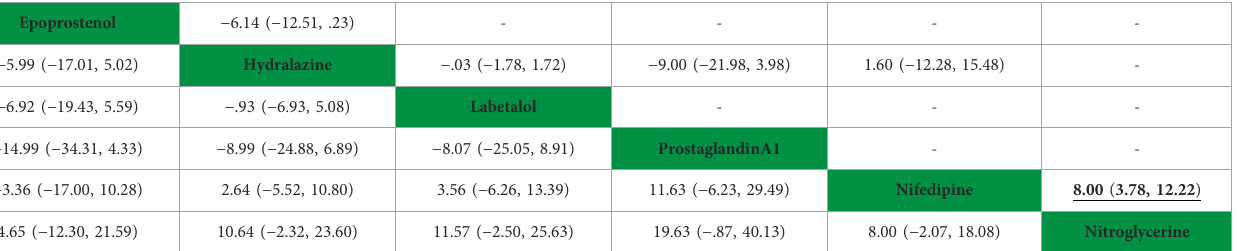
TABLE 5 Network comparison and direct comparison results for systolic blood pressure (mmHg). Epoprostenol